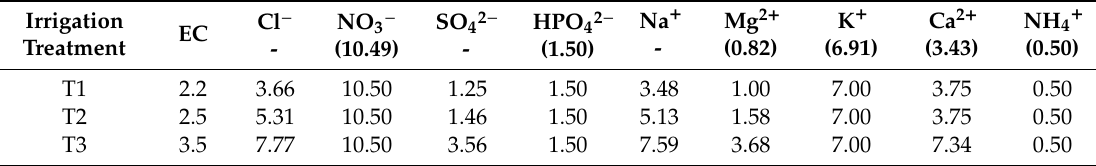
Table 1. Chemical properties (electrical conductivity (EC; dS / m), anions (mmol / L) and cations (mmol / L) for desalinated seawater with low EC (T1), well / desalinated water with intermediate EC (T2), and well water with high EC (T3)). Values between parentheses represent the set values proposed by Urrestarazu